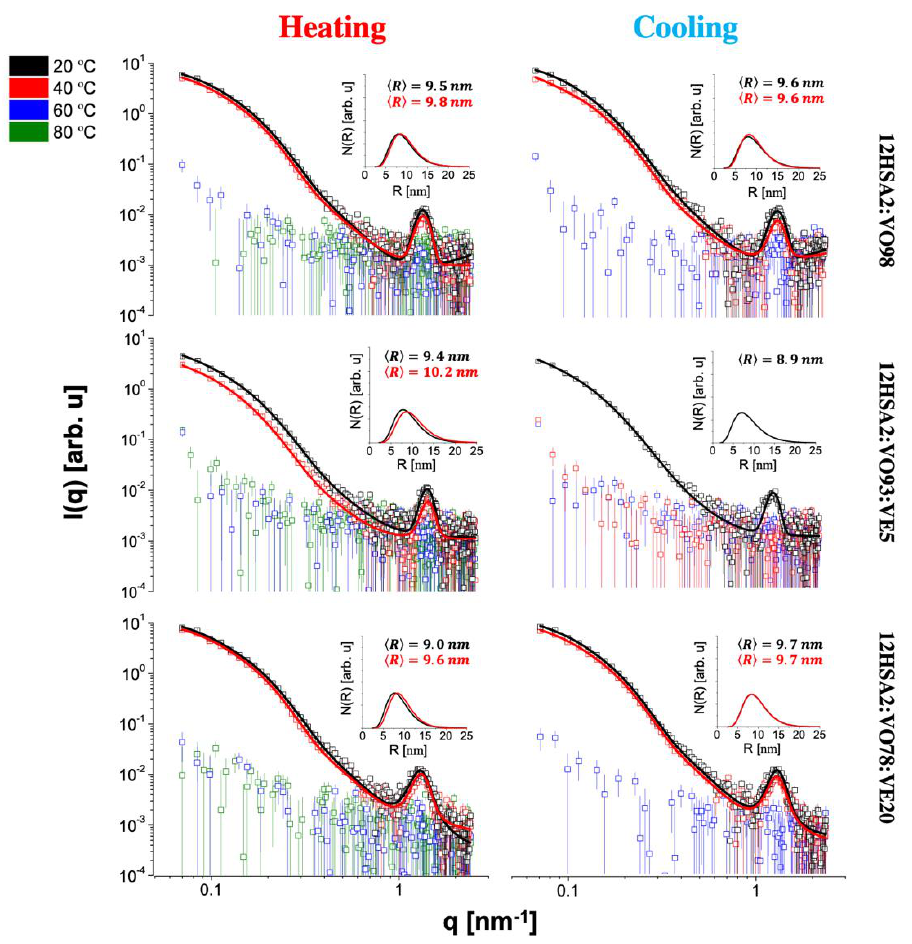
Figure 5. Small-angle X-ray scattering (SAXS) data for the 12-HSA organogels on heating and on cooling (open symbols) and fitted with Equation (12) (continuous lines). The insets correspond to the cylinder radius size distributions. The average radius for each distribution is shown as well.